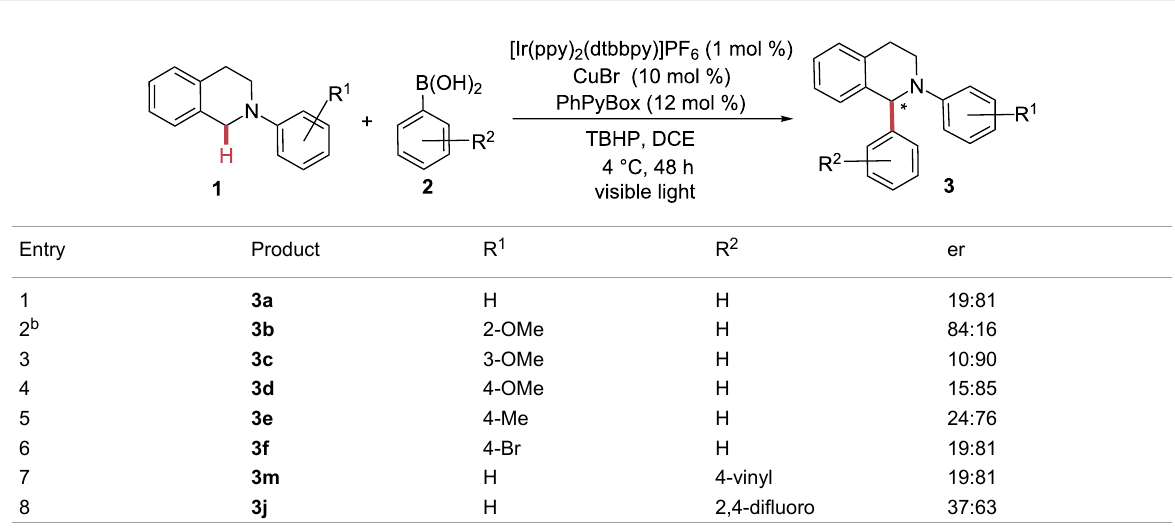
Table 3: Enantioselective arylation reaction a